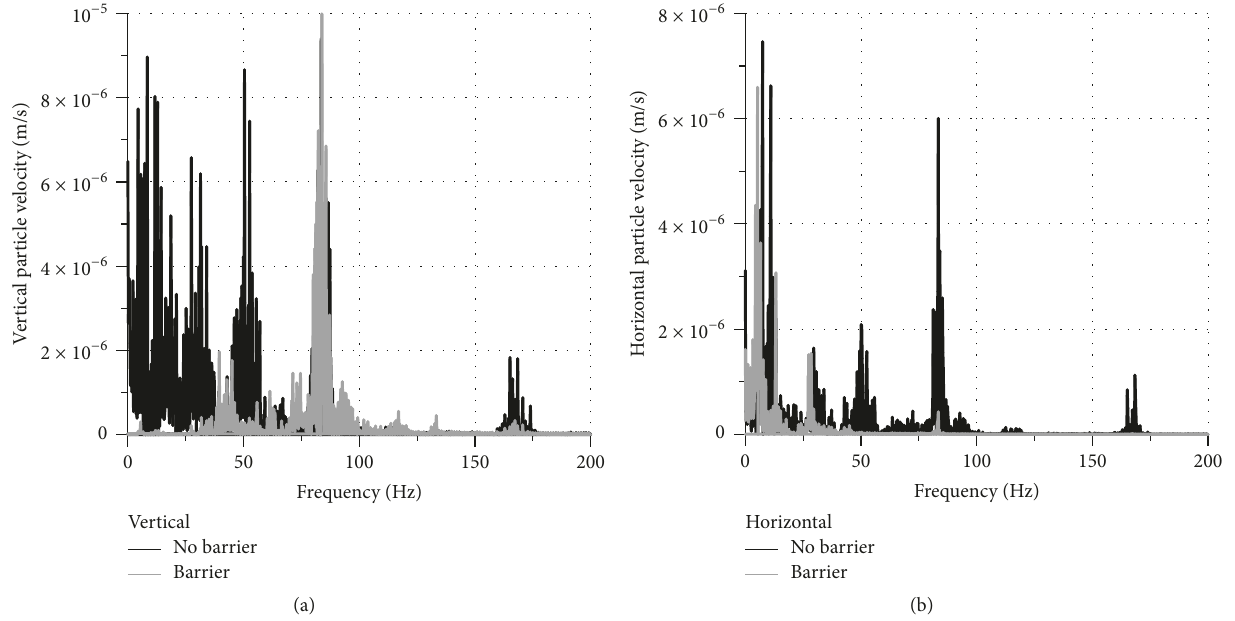
Figure 13: Spectral comparison of vertical vibrations in the foundation slab with (grey) and without (black) a wave barrier.